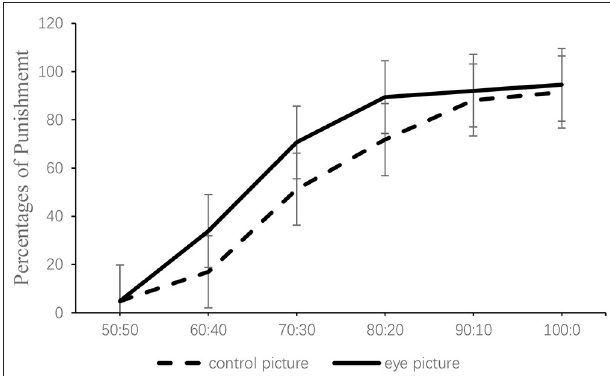
Third-Party Punishment